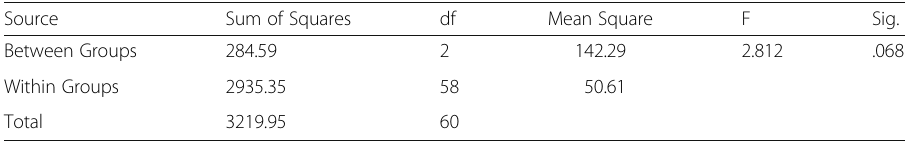
Table 2 ANOVA results for the proficiency test Source